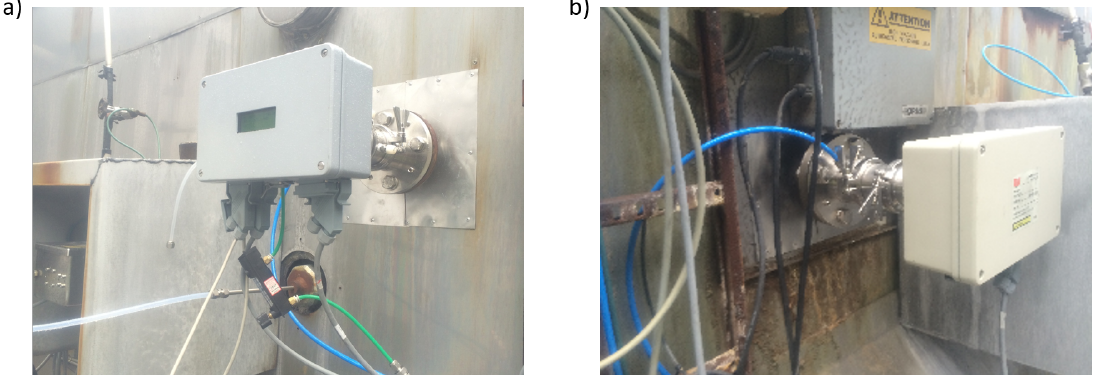
Figure 5. Photograph of ( a ) transmitter unit and ( b ) receiver unit installed at an exhaust duct of an Alcoa Aluminum smelter.